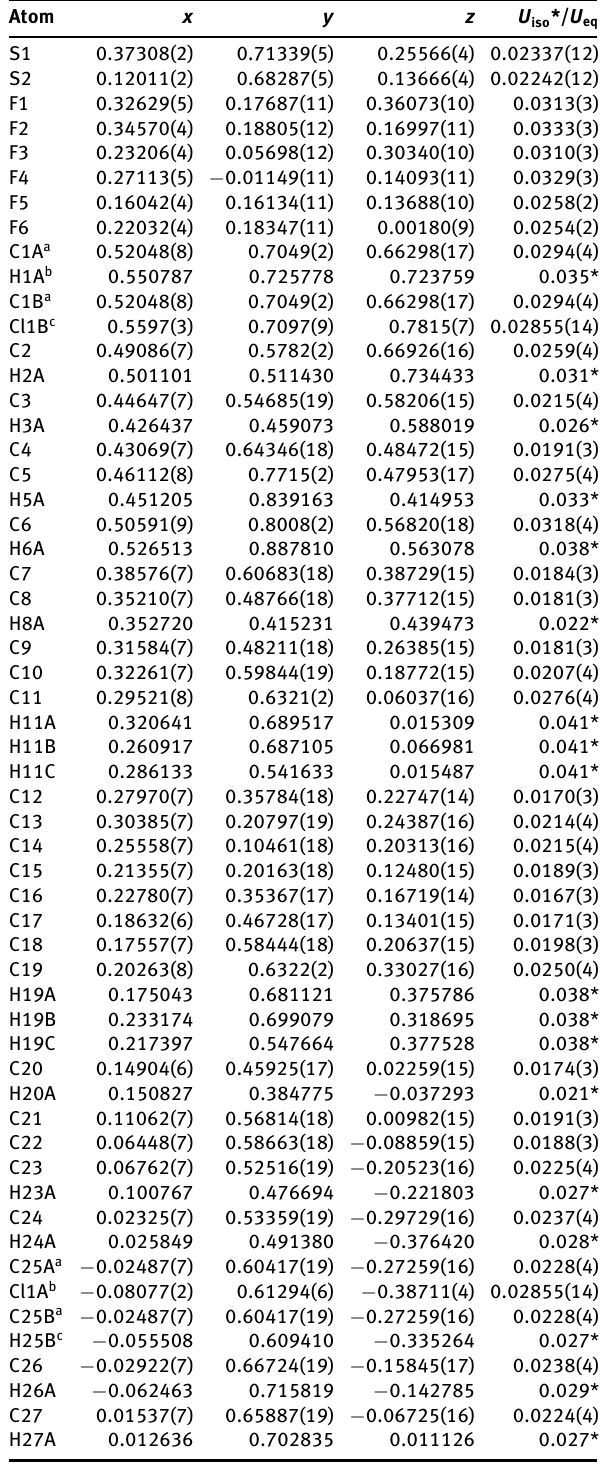
Table 2: Fractional atomic coordinates and isotropic or equivalent isotropic displacement parameters (Å 2